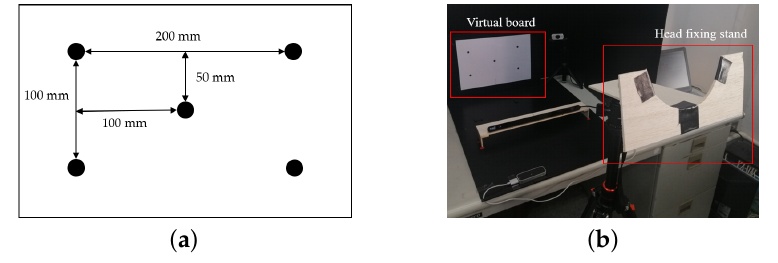
Figure 24. Virtual board: ( a ) Layout of points on a virtual board, ( b ) Photograph of a virtual board with a head fixing stand.